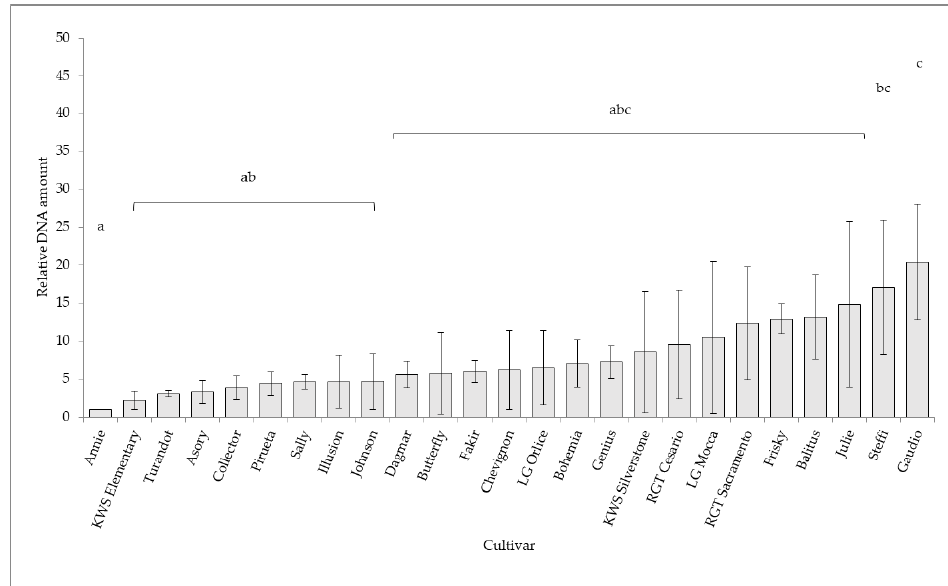
Figure 1. The qPCR assessment of Oculimacula yallundae in the winter wheat cultivars (2019–2021). In the ANOVA with a multiple comparison Fisher´s LSD test ( p < 0.05), homogeneous groups are marked with the same letters.